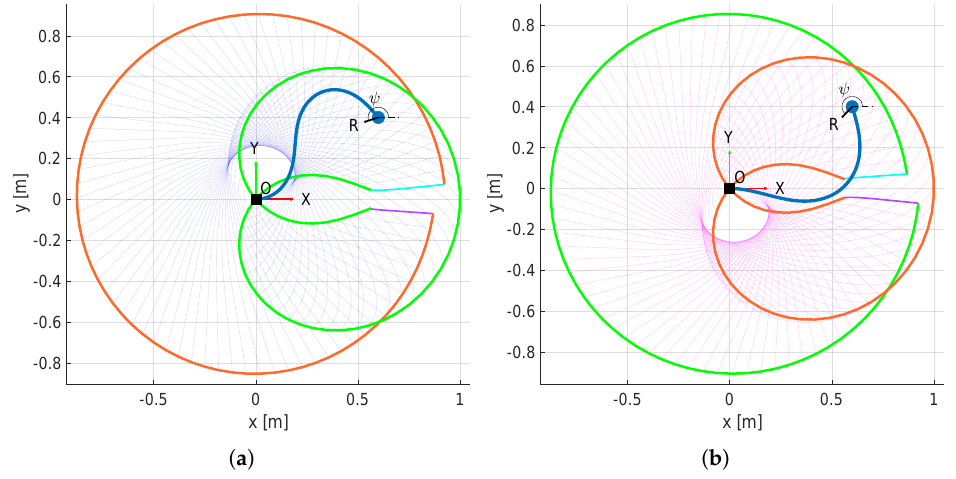
Figure 6. Rod’s end-tip workspace for buckling mode 2. ( a ) Positive k . ( b ) Negative k . As for the orange lines in Figures 5 and 6, they come from the calculation of the rod’s end-tip position for the higher limit of the range of k and varying ψ . The green lines are calculated with the lower limit of the interval of k and varying ψ . To close the workspace area, the purple lines are plotted. They are related to the calculation with the higher limit of the interval of ψ and varying k . In contrast, the cyan lines derive from the computation with the lower limit of the interval of ψ and varying k .